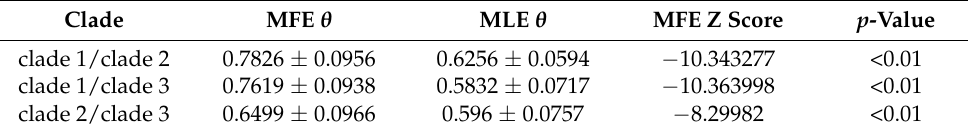
Figure 7. Phylogenetic relationships, conserved domains and motifs analysis of TEPs of 12 fig wasps. ( A ) The phylogenetic tree was constructed using the amino acid sequences of TEPs of 12 fig wasp species, D. melanogaster (Dmel), A. mellifera (Amel), N. vitripennis (Nvit) and P. puparum (Pp), and the optimal model was JTTDCMut+F+R5. The TEPs were clustered into three clades. ( B ) The distributions of conserved motif in TEP genes. 10 motifs were displayed in different colored boxes. ( C ) The domains of TEP genes. Each clade had specific domain features. Table 4. Functional divergence analysis of three clades of TEP genes.